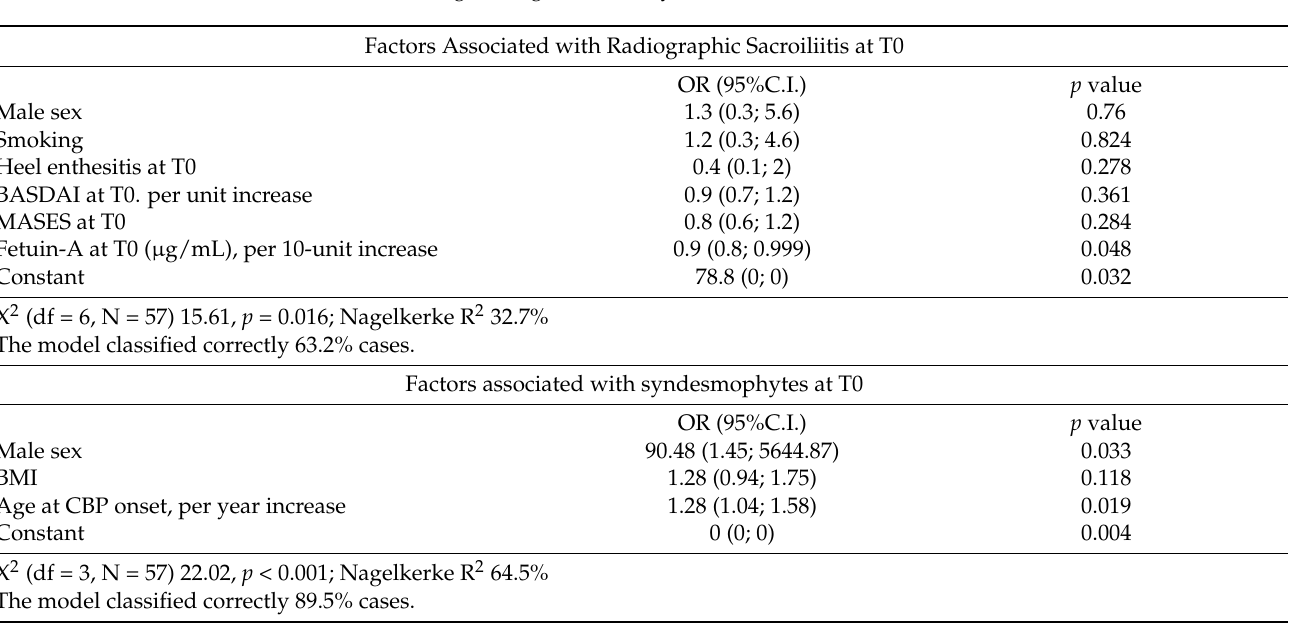
Table 2. Factors associated with radiographic sacroiliitis and syndesmophytes at T0, results of multivariate logistic regression